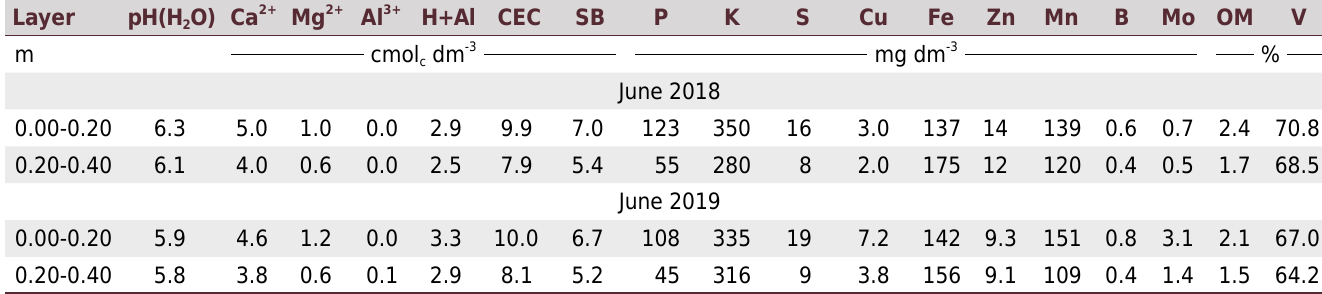
Table 1. Chemical soil characterization of the experimental area at layers of 0.00-0.20 and 0.20-0.40 m Layer pH(H 2 O) Ca 2+ Mg 2+ Al 3+ H+Al